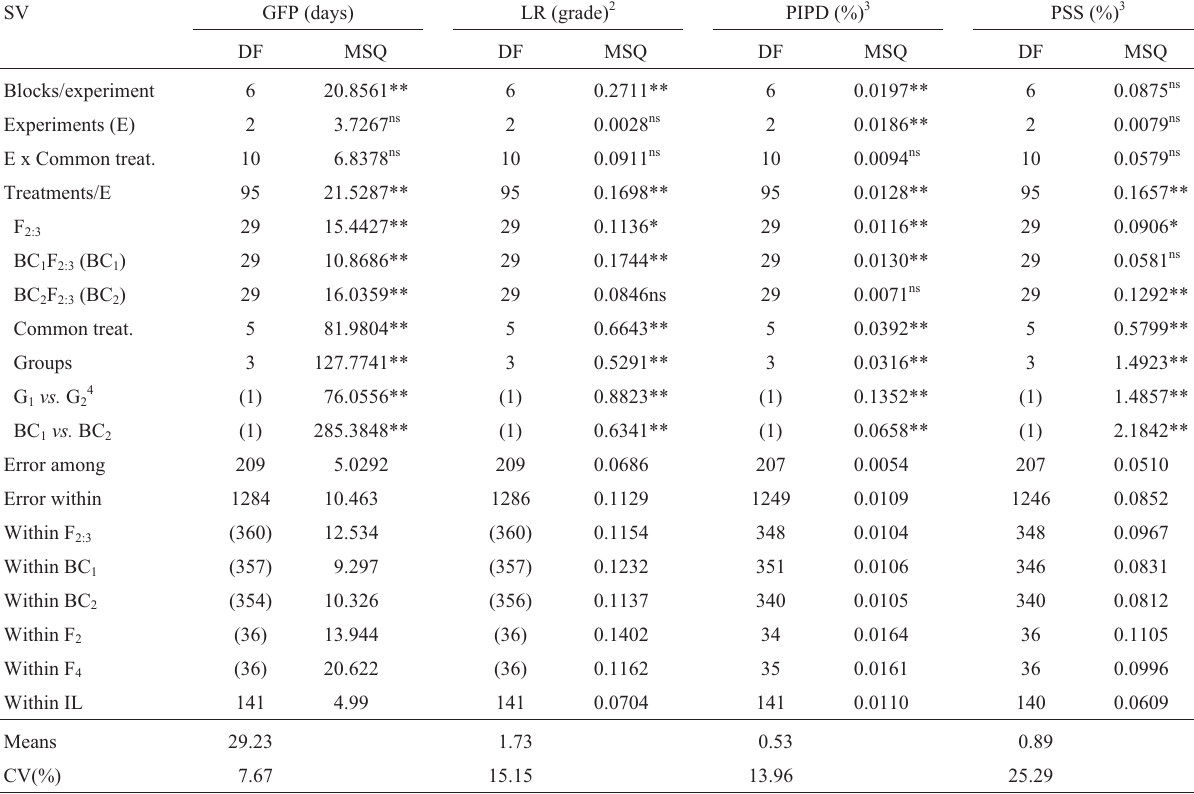
Figure 1 - Fluctuation of the average stink bug population in the experi- ment during the period comprised between reproductive stages R 3 and R 8 of the evaluated Table 1 - Summary of the joint analysis of variance, with the mean squares associated to variation among the means and within the plots, from their re- spective sources of variation, for traits associated to resistance against the stink bug complex (GFP, LR, PIPD and PSS) 1 in soybean. SV GFP (days)